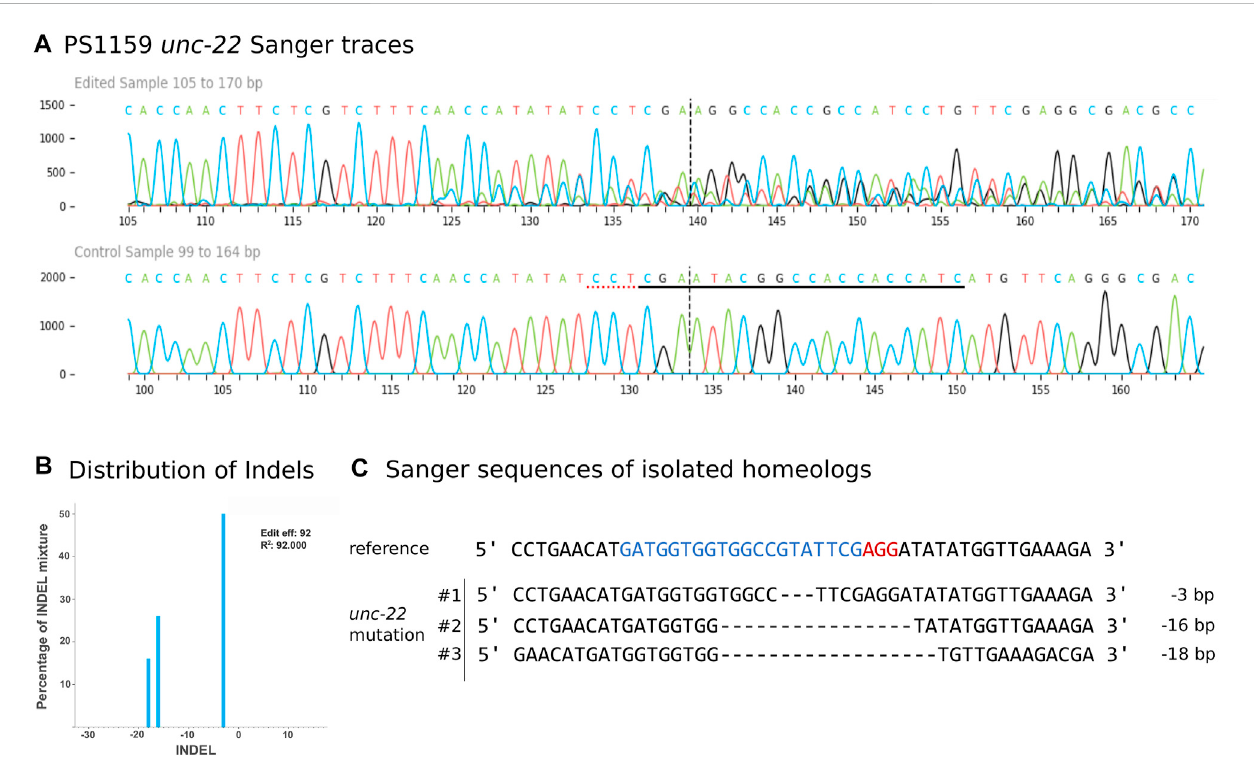
FIGURE 4 (A) Panagrolaimus sp. PS1159 unc-22 Sanger Sequencing traces after PCR of edited and wild-type (control) in the region around the guide sequence using the Synthego Performance Analysis, ICE Analysis. 2019. V3.0. Synthego. Black underlined region shows the guide sequence. Red underline represents the PAM site. Vertical dotted line shows expected cut site. (B) Predicted distribution and percentage of Indels in the entire population of genomes using ICE. (C) Sanger sequencing reveals deletions in isolated homeologs #1-#3 after DNA cloning. Target region (blue) and PAM site